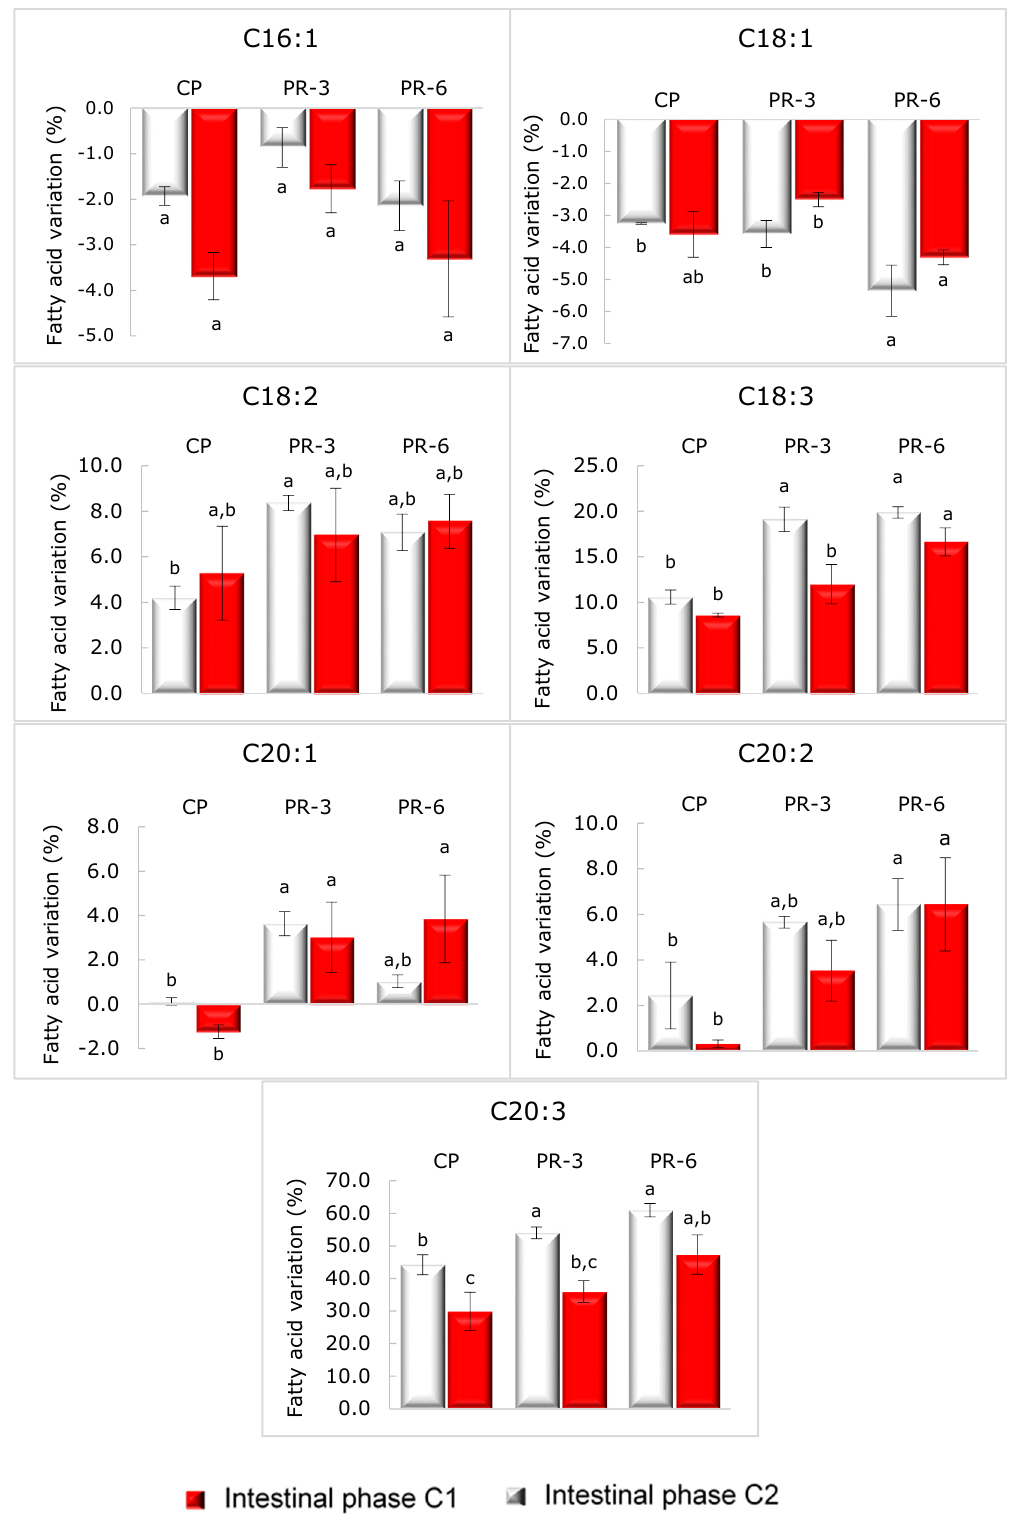
Figure 6. Unsaturated fatty acid variations of pork liver pâté samples. CP: Control pork liver pâté; PR-3: Pork liver pâté with 3% Rojo Brillante flour; PR-6: Pork liver pâté with 6% Rojo Brillante flour after digestion. Values with different letter indicates significant differences ( p < 0.05), according to Tukey’s post host test.